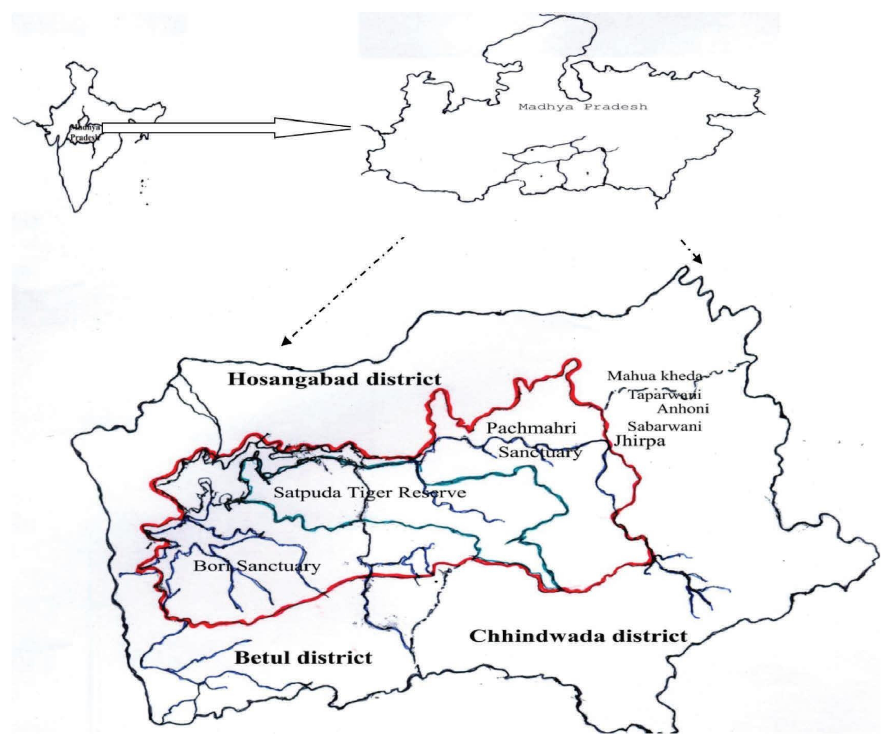
Figure 1: Location map of the Pachmarhi biosphere reserve in